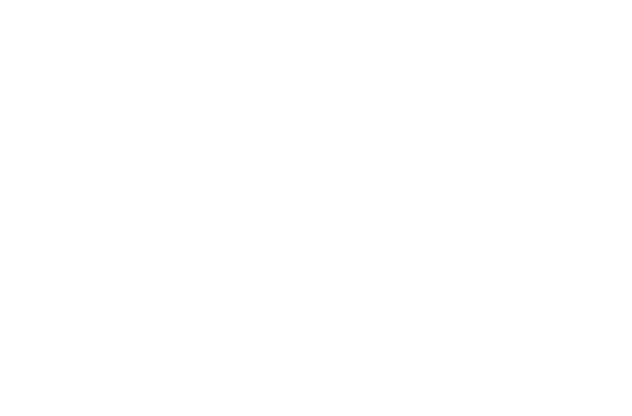
Figure 2. Pre-treated residual fat used as feed material by catalytic upgrading of residual fat vapors at 400 °C, 1.0 atm, 0.0%, 5.0%, 7.5%, and 10.0% (wt.) activated carbon pellets impregnated with 10.0 M NaOH, using a catalyst fixed-bed reactor, in semi-pilot scale.